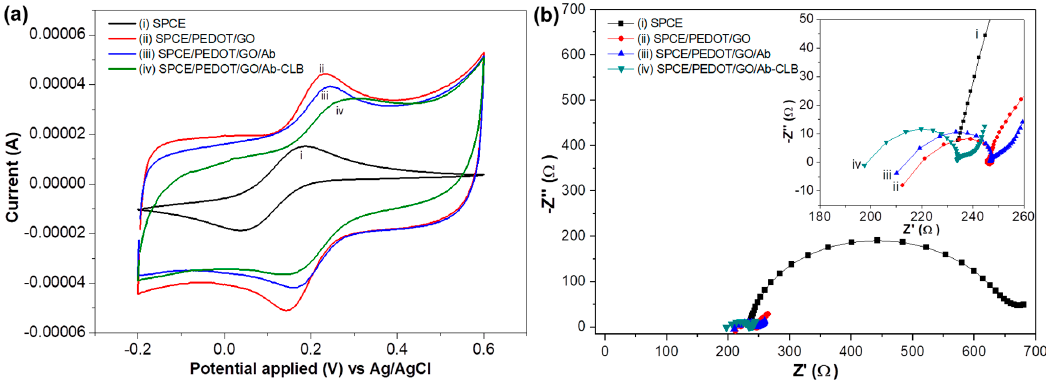
Figure 2. ( a ) Cyclic voltammetrys (CVs) of (i) bare screen-printed carbon electrode